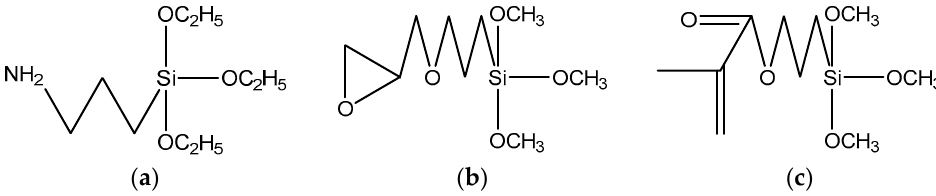
Figure 7. ( a ) Simplified structure of KH550; ( b ) simplified structure of KH560; ( c ) simplified struc- ture of KH570.